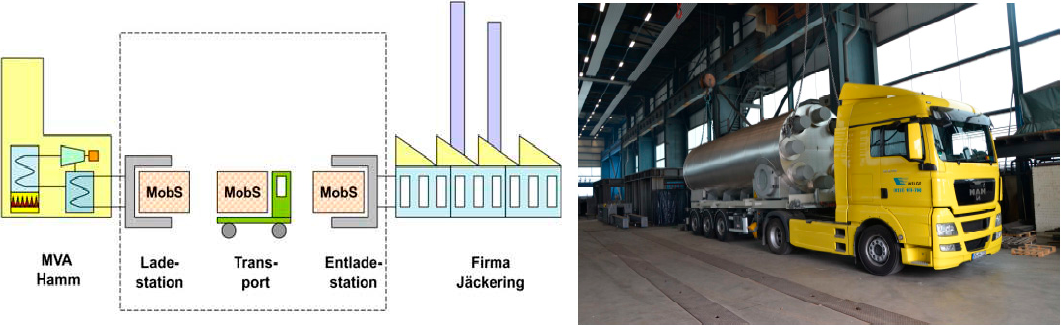
Figure 9. An adsorption based dishwasher. Washing phase ( a ); drying phase ( b ).